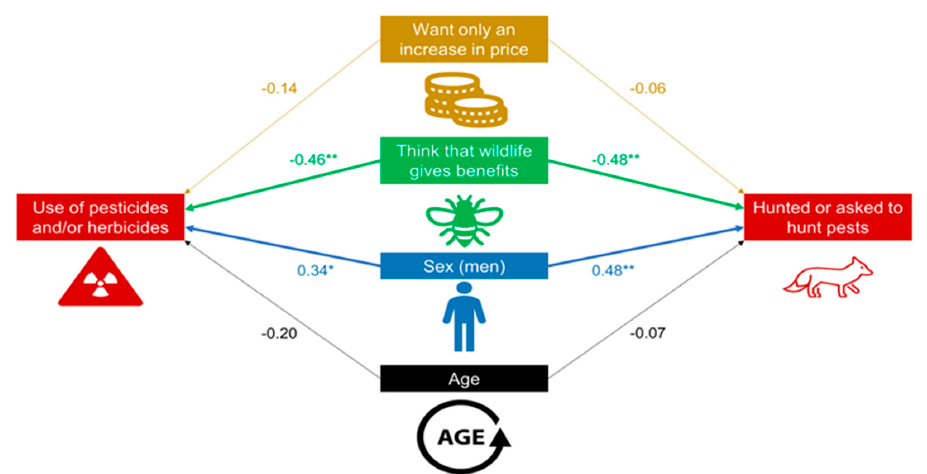
Figure 4. Representation of the structural equation model to understand the determinants of use of pesticides and/or herbicides and hunting of and requests to hunt pests (endogenous variables) in 25 coffee farmers is Pangauban, West Java. Thick arrows starting from the exogenous variables indicate significant relationships. * p < 0.05; ** p < 0.01 .